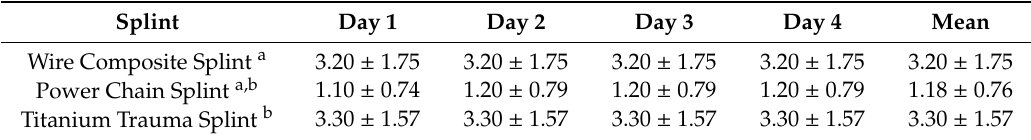
Table 2. Esthetic of the splints.